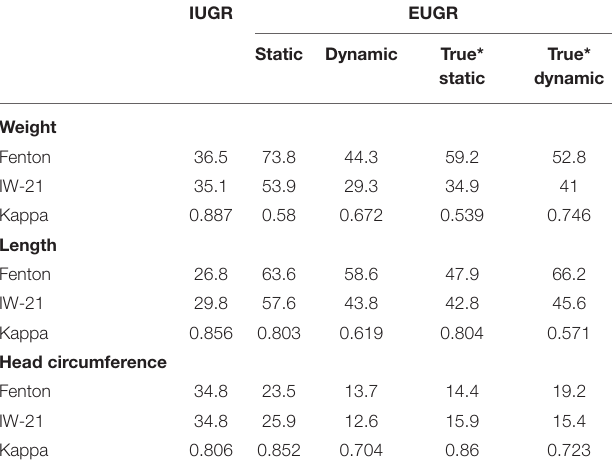
TABLE 5 | Prevalence of IUGR, EUGR (static and dynamic), and “true EUGR” according to Fenton 2013 and INTERGROWTH-21st and Kappa concordance between both